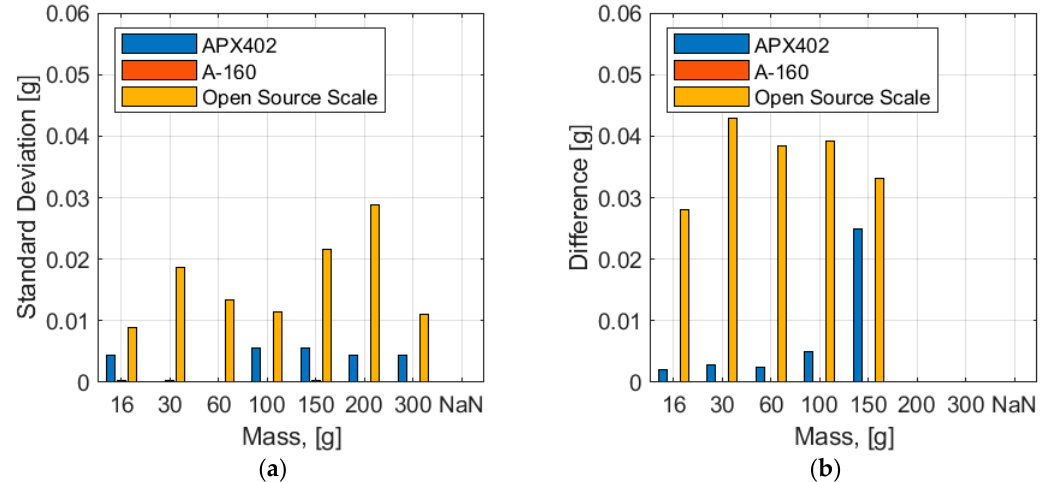
Figure 10. The 5kg load cell results are shown ( a ) The standard deviation (sample of 5 measurements) averaged to 0.0163 g. This is large relative to the APX402 and the A-160; ( b ) The absolute value of the difference between each scale and the A-160 is shown. The open-source scale averaged a difference of 0.0363 g.